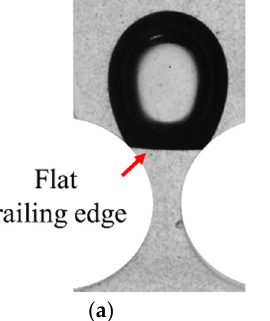
Figure 7. Pinning of a bubble existing a smooth pore interface at ( a ) 0.1 mL/min and ( b ) 0.3 mL/min.